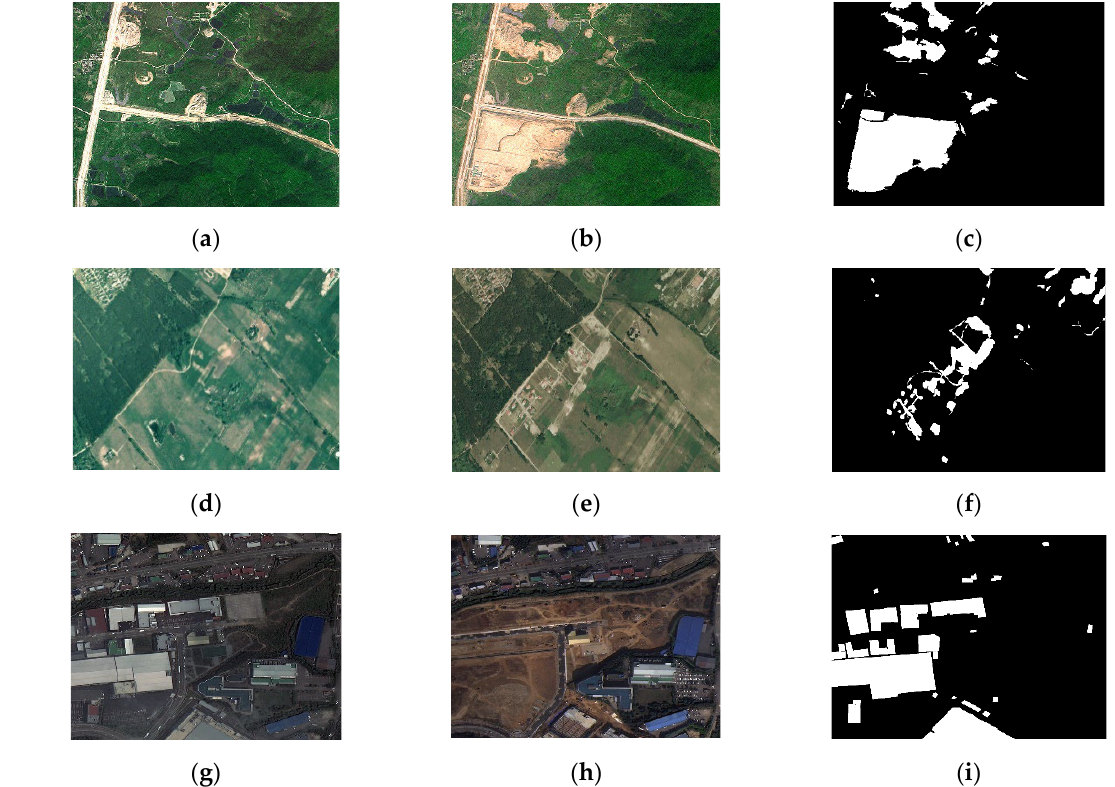
Figure 2. Experimental datasets and ground truth images for change detection: ( a ) SPOT images acquired in 2006 with a spatial resolution of 2.5 m; ( b ) SPOT images acquired in 2007 with a spatial resolution of 2.5 m; ( c ) reference change map of DS1. ( d ) aerial images acquired in 2000 with a spatial resolution of 1.5 m; ( e ) aerial images acquired in 2005 with a spatial resolution of 1.5 m; ( f ) reference change map of DS2. ( g ) side-view satellite images acquired in 2017 with a spatial resolution of 0.5~0.8 m; ( h ) side-view satellite images acquired in 2020 with a spatial resolution of 0.5~0.8 m; and ( i ) reference change map of DS3.